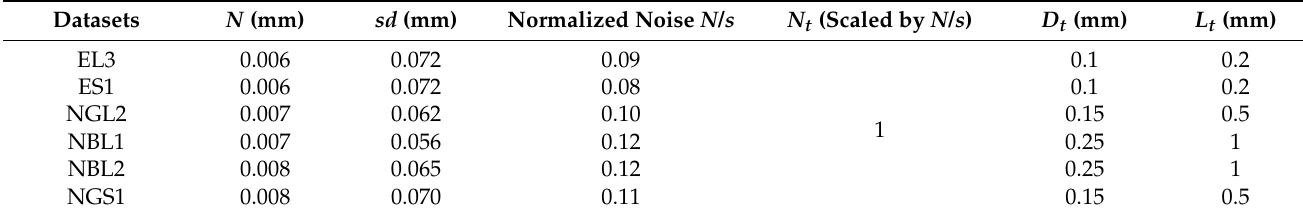
Table 10. Calculated and user input parameters for Case Study II.